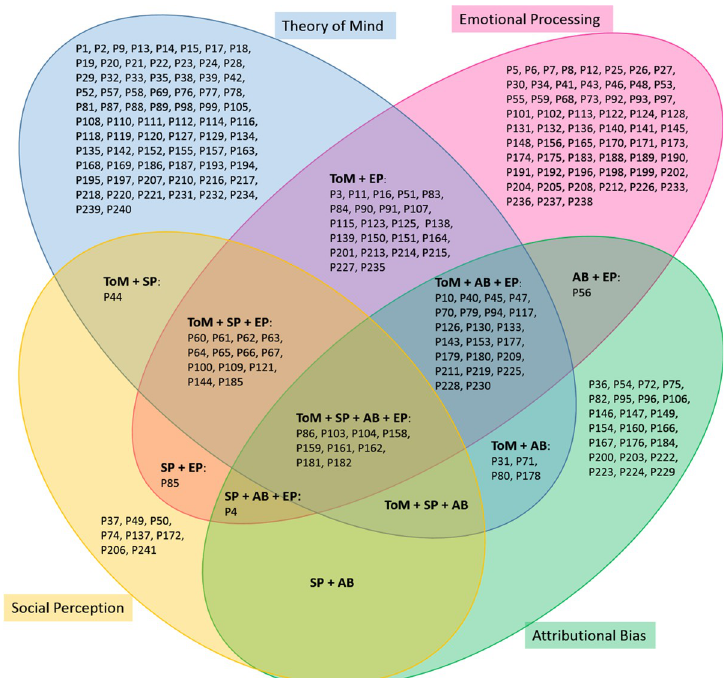
Fig 3. References by domains of social cognition. Venn diagram with four sets.